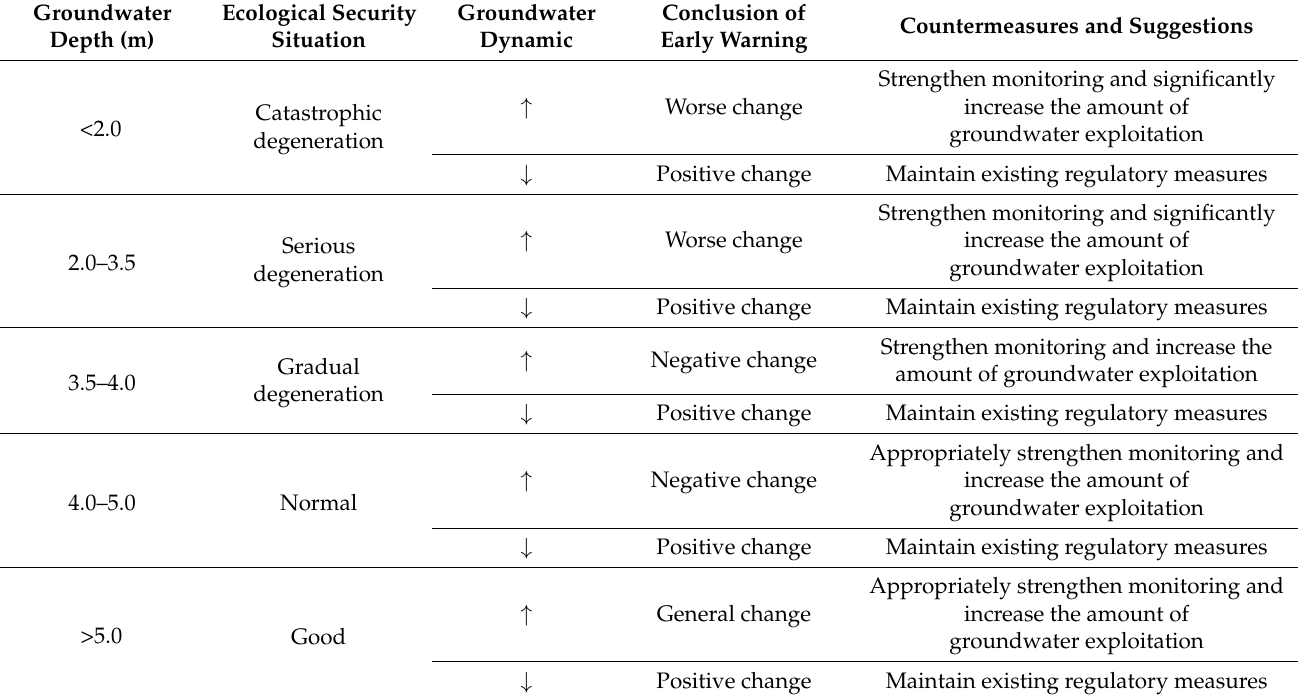
Table 6. Ecological security early warning and management threshold index system of farmland